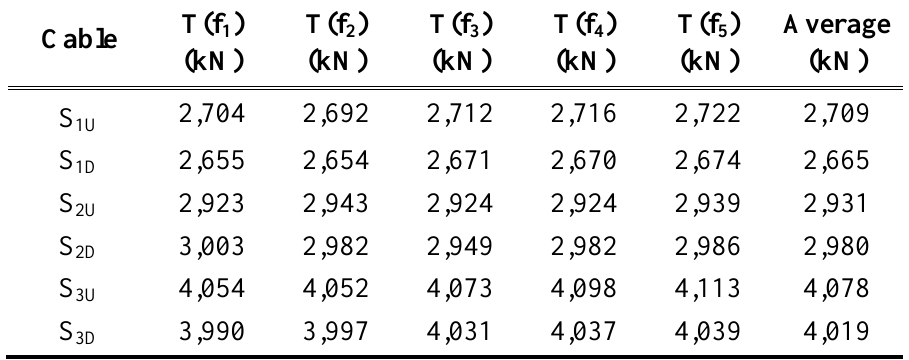
Table 2. Radar-based tensions in the forestays of the cable-stayed bridge over the river